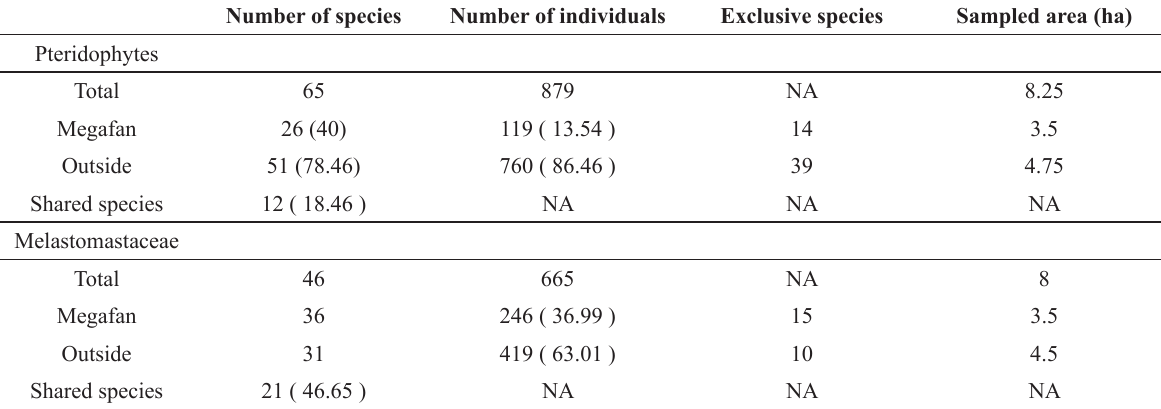
Summary of data for pteridophytes and Melastomataceae collected in 33 plots in the study area. The plots were classified according to their occurrence in the megafan sediments and in the basement